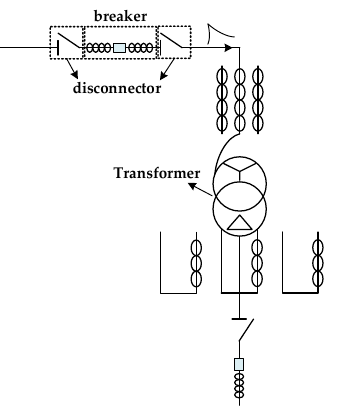
Figure 2. Simplified GIS substation wiring diagram.